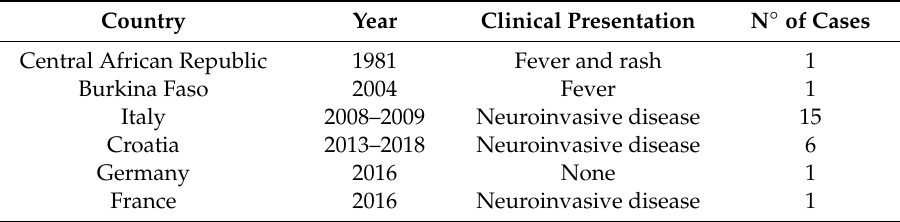
Table 2. Human cases of Usutu virus (USUV) infection. Country Year Clinical Presentation N ◦ of